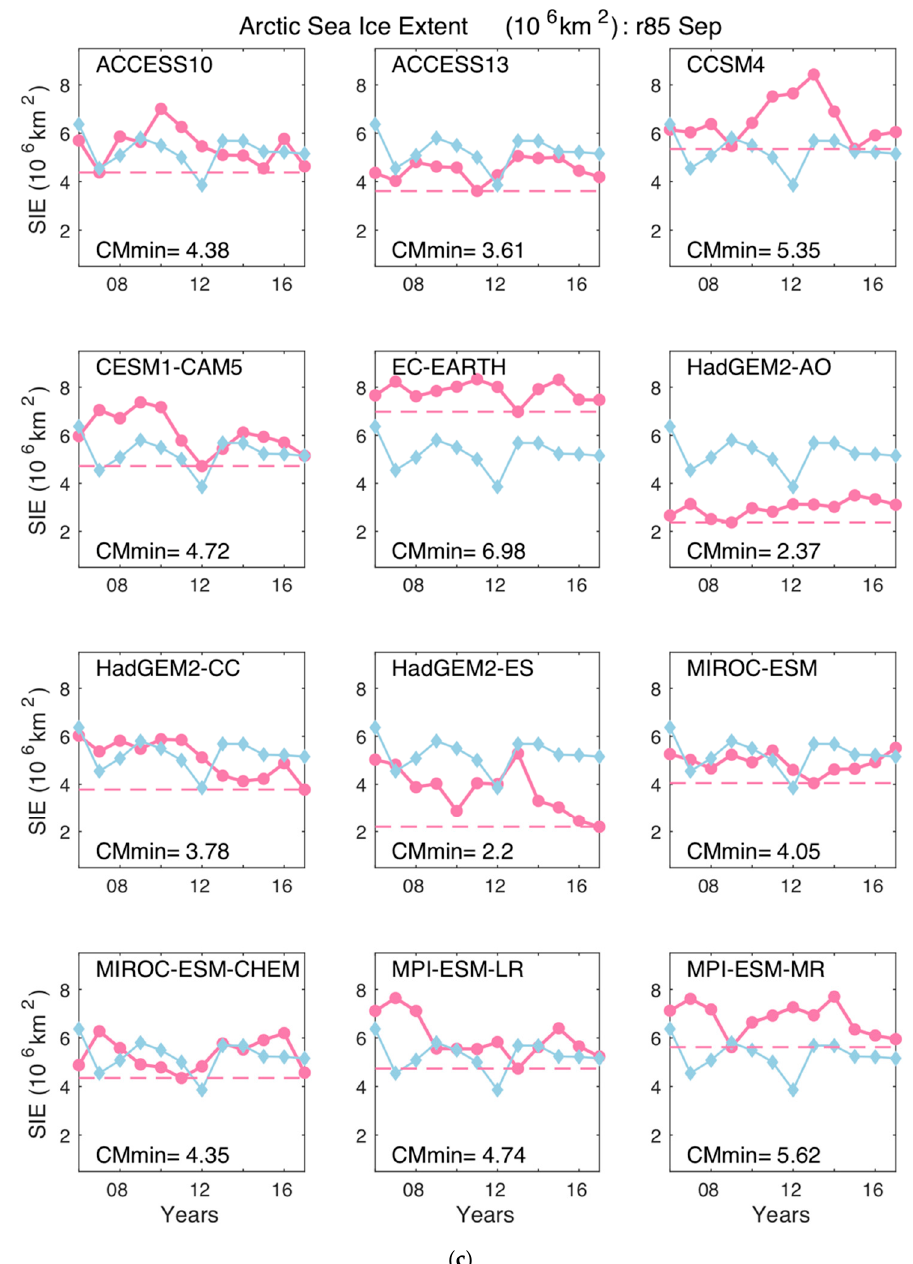
Figure 5. ( a ) Time series of simulated Arctic sea ice extents in September by individual climate model (blue solid lines with filled circles) overlaid with the satellite data (light blue solid lines with filled diamonds) for the period of 1979–2005. Dashed lines denote the minimum of the model extent values for the time period, and these values are included in the plots. ( b ) The same as for Figure 5a except for the projected September Arctic sea ice extents for the RCP4.5 scenario (green) for the period of 2006–2017. ( c ) The same as in Figure 5b except for the RCP8.5 scenario (pink).